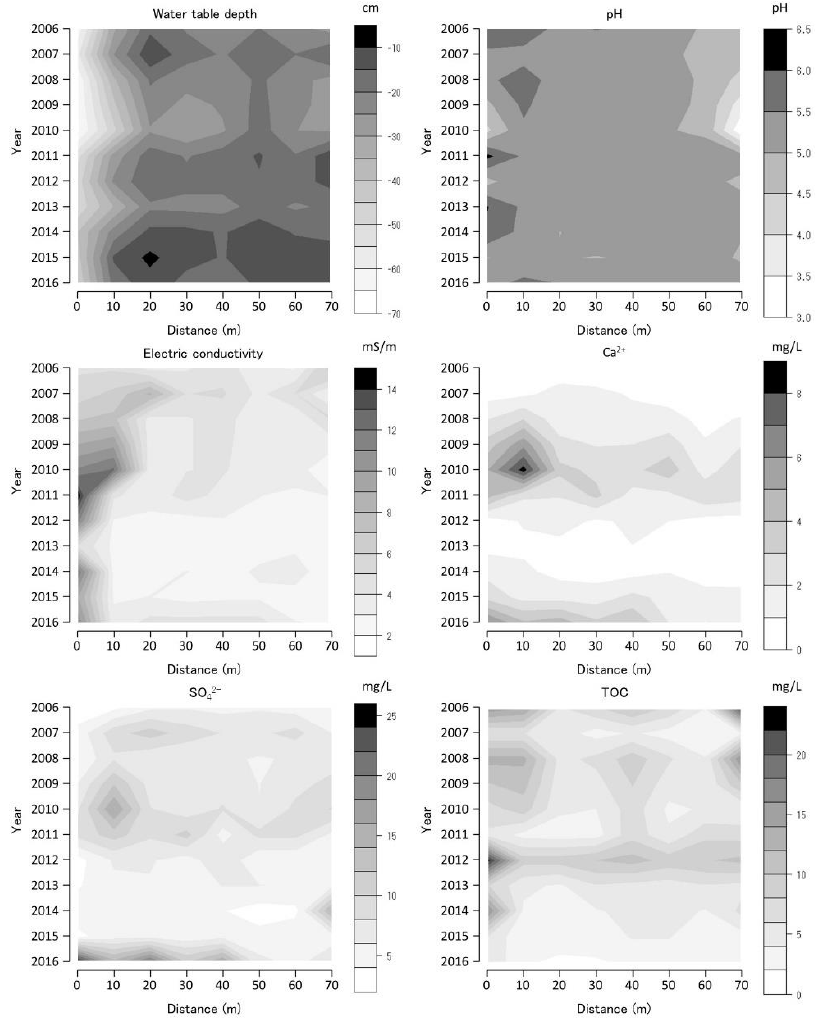
Figure 7. Water-table depth (WTD), pH, electric conductivity (EC), calcium ion concentration (Ca 2+ ), sulfate ion concentration (SO 42 − ), and total organic carbon (TOC) along Bougatsuru transect 1 (BGT transect 1). Data were collected at 8 sites of water environment monitoring with 10 m intervals along the transect. Countered figures of chemical variables on the axes of year and position were drawn by interpolating missing data (in 2008 and